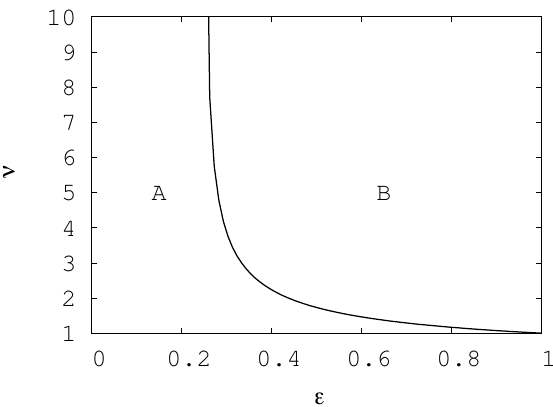
Figure 5 . Regions A and B in ( (cid:15); (cid:23) ) plane. The angular momentum J and the speci(cid:12)c heat C J are negative in region A and positive in region B . C V decreases with temperature in region A and increases in region B . C A increases with temperature in region A and decreases in region B .